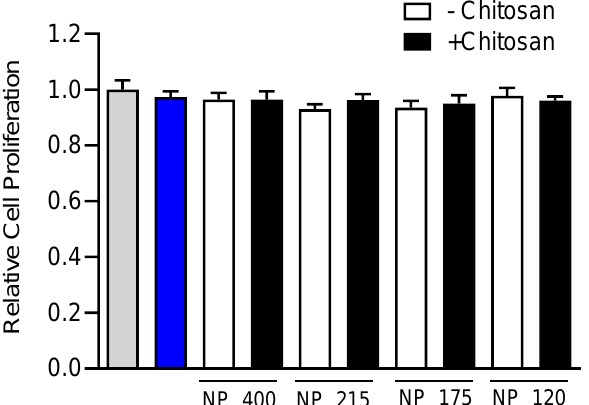
Figure 5. Effect of simvastatin treatment on cell proliferation. HT-29 mucosal epithelial cells were cultured in the presence of media alone (gray bar), 10 µM simvastatin, (blue bar), or control (white bars) or chitosan-containing (black bars) nanoformulations for 72 h. Proliferation was assessed with an MTS assay, and drug or NP induced changes in proliferation were compared to media-treated control. Values are means ± SD. n = 6, one-way ANOVA followed by Tukey’s multiple comparisons test.